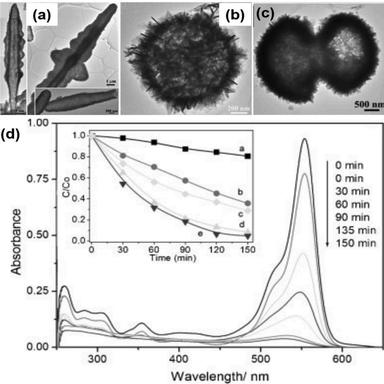
TEM images of: (a) hollow WO3 dendrites, (b) hollow WO3 spheres, (c) single WO3 hollow dumbbell. (d) Changing UV–Vis spectrum for rhodamine B aqueous solution in the presence of WO3 hollow spheres under visible light irradiation. The Inset is rhodamine B concentration changes over a) photolysis b) commercial WO3 c)–e) WO3 hollow dumbbells, hollow dendrites and hollow spheres (calcined at 500 �C for 2 h), respectively. Rhodamine B solution: 100 mL, 4 mg L 1 ; catalyst 0.3 g; 300W Xe-lamp (λ > 420 nm) Reprint